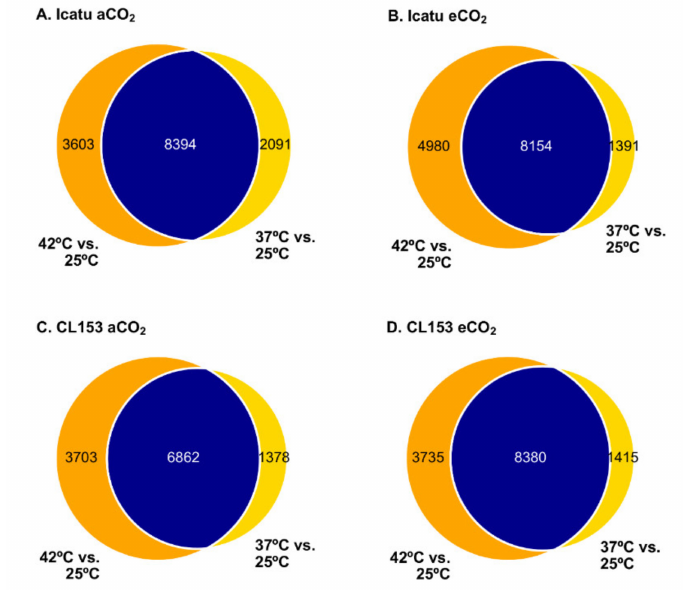
Figure 2. Transcriptional patterns among differentially expressed genes (DEGs) between the two supra-optimal temperatures of 37/28 ◦ C (37 ◦ C) and 42/30 ◦ C (42 ◦ C). Numbers represent the DEGs shared between treatments (blue), specific for 37 ◦ C (yellow) and specific for 42 ◦ C (orange), found in plants of Icatu ( A , B ) and CL153 ( C , D ) grown under 380 µ L L − 1 aCO 2 or 700 µ L L − 1 eCO 2 . The number of up- and down-regulated DEGs in plants at 37 ◦ C and 42 ◦ C was nearly the same in both genotypes, except at 42 ◦ C in eCO 2 where DEGs were predominantly up-regulated in Icatu (Figure 3). The expression profiles of specific DEGs were particularly influenced by the highest temperature, especially in Icatu which displayed a higher degree of variation (Figure 4). By contrast, the expression profile of the two genotypes exhibited a small differentiation at 37 ◦ C.